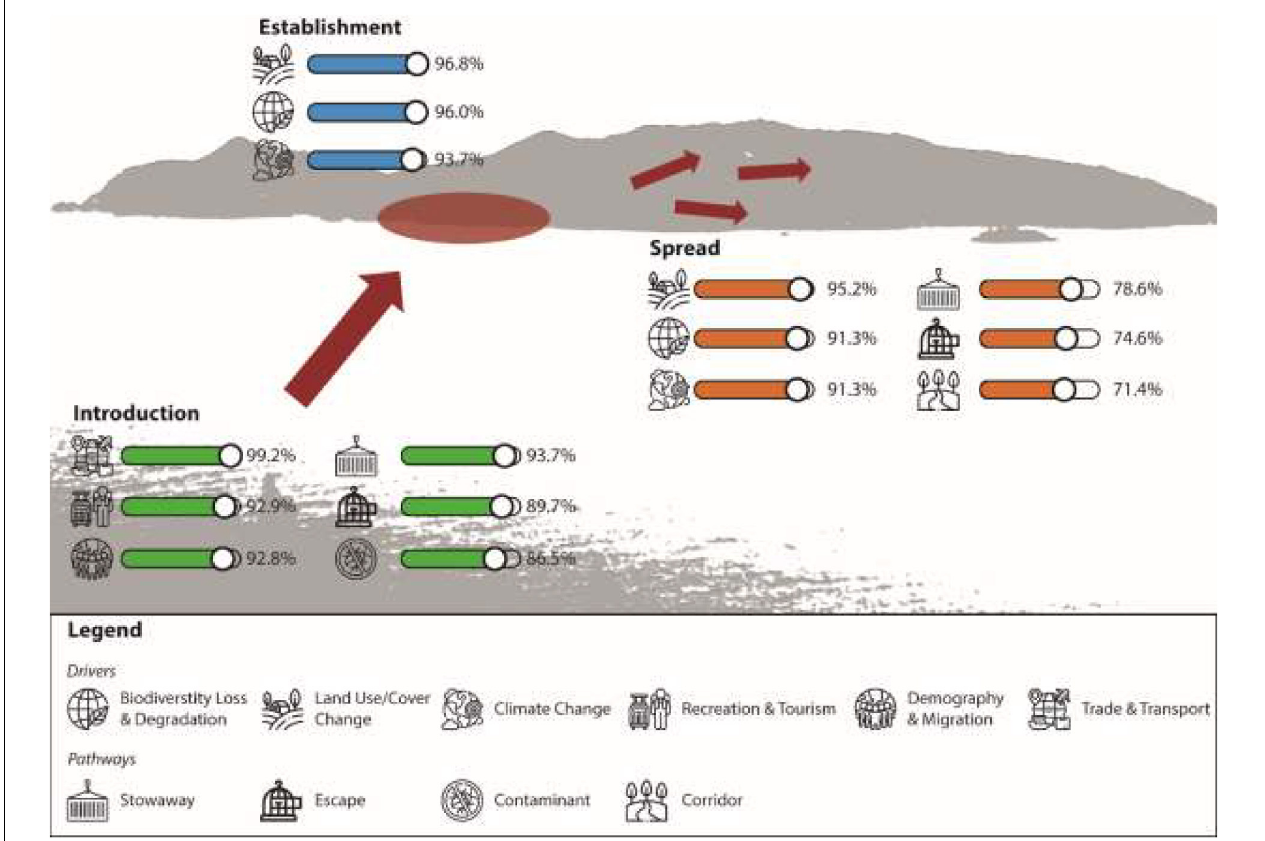
FIGURE 1 | Summary of the three main drivers of alien species richness for all invasion stages and the three main pathways of alien species introduction and spread contributing to substantially to an increase of alien species richness. Values are given for the percent of combined answers in the categories “agree” and “strongly agree.” Icons are made by ”Freepik” from